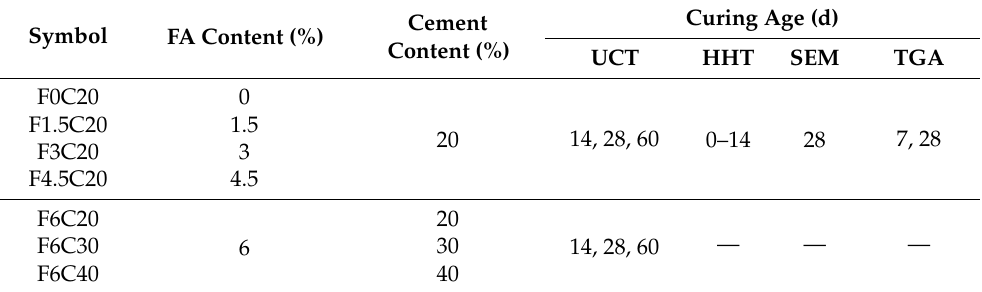
Table 3. Mix design and test